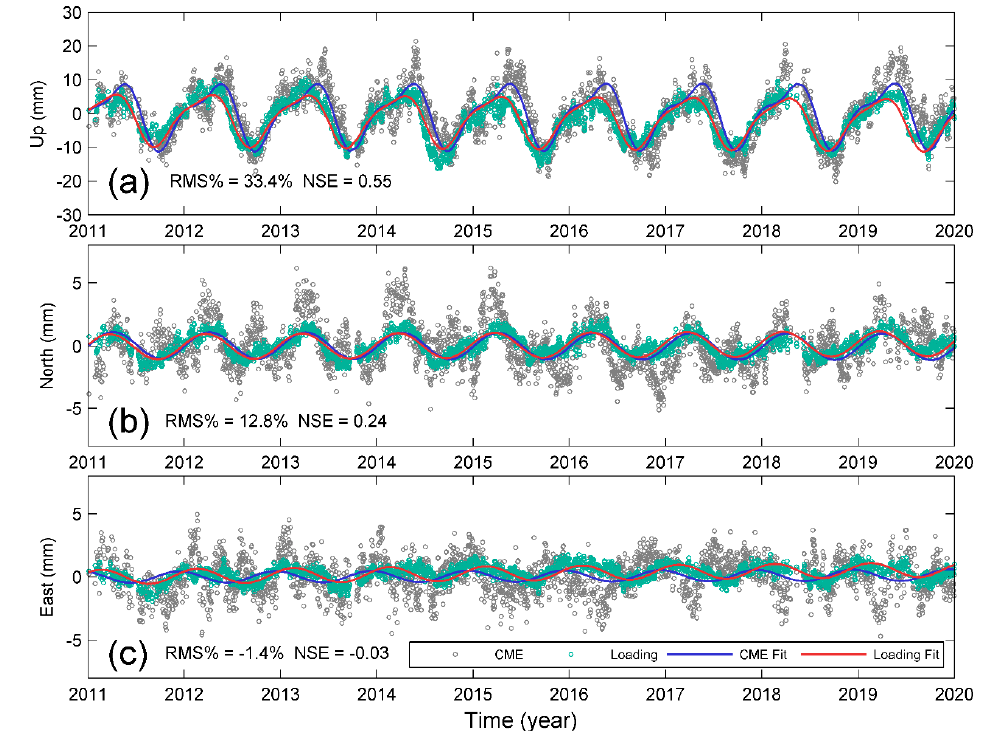
Figure 8. Comparison between rCMEs and combined loading deformation for ( a ) up, ( b ) north, and ( c ) east components, respectively. The loading deformation is a combination of elastic response to NTAL, NTOL, and HYDL provided by Dill and Dobslaw [32]. The RMS% denotes the RMS reduction for each component. The curves in blue and red denote the modeled annual and semi-annual variations for rCMEs and loading deformation, respectively.